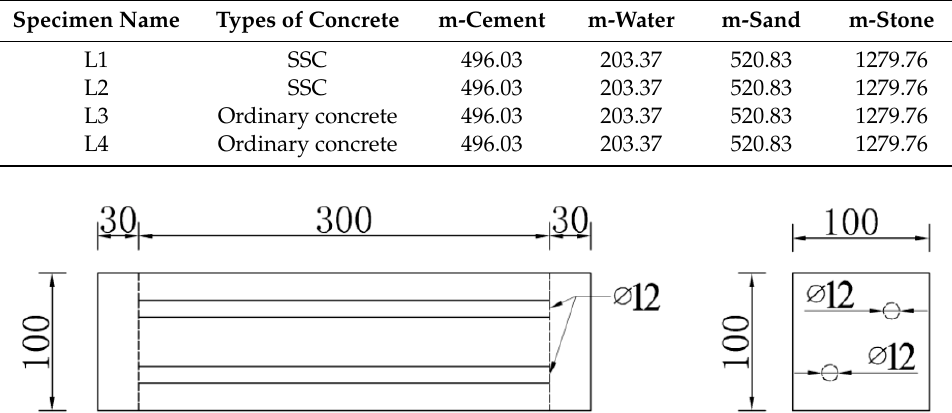
Figure 1. Sectional dimensions and reinforcement of specimens (Dimensions are in mm).